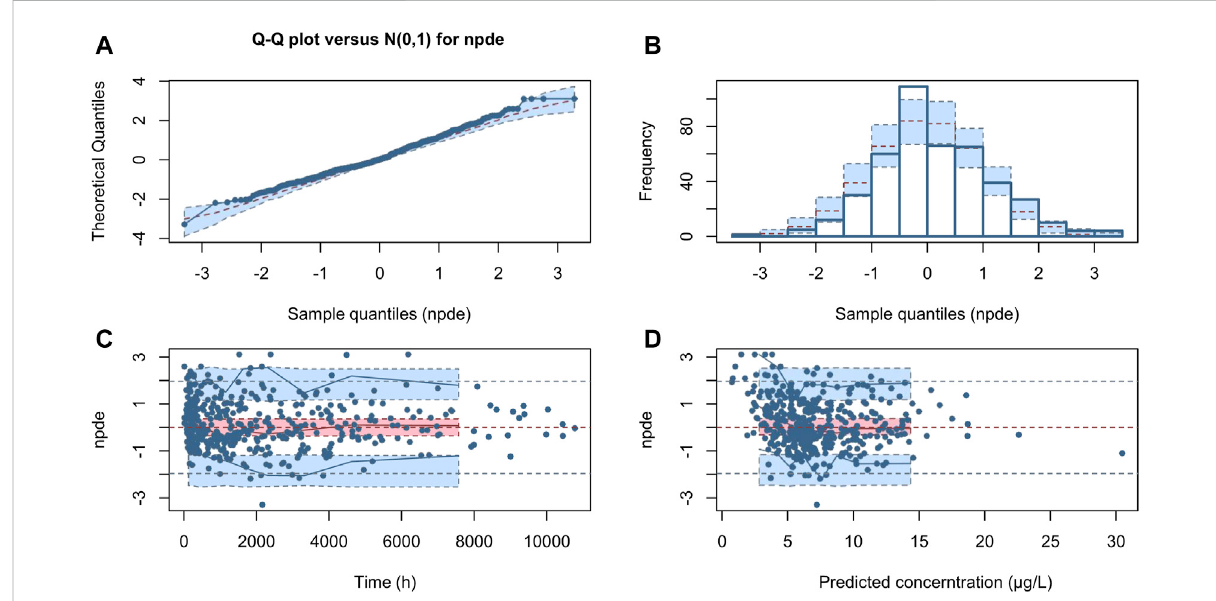
FIGURE 4 Normalized prediction distribution error (NPDE) for the fi nal model. Quantile-quantile plots of NPDE vs. the expected standard normal distribution (A) . Histogram of NPDE values with the standard normal distribution overlayed (B) . Scatter plot of the time vs. NPDE (C) . Scatterplot of predictions vs. NPDE (D) .